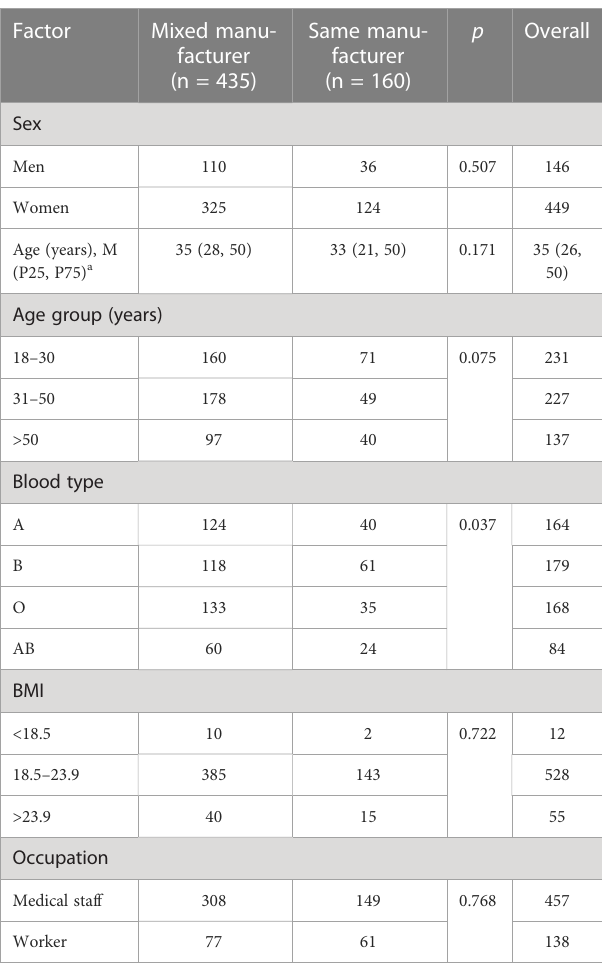
TABLE 1 Baseline characteristics of the study participants (N =